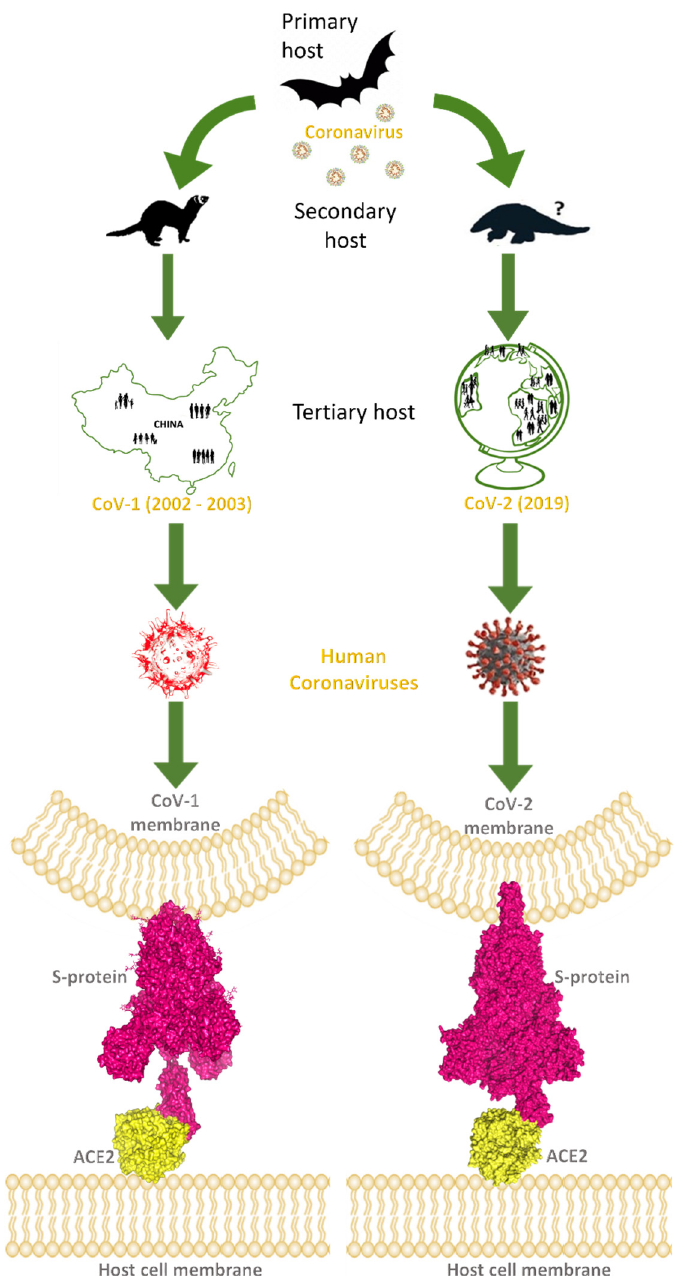
Figure 1. This image explains how coronaviruses spread from bats, as primary hosts, to humans, as tertiary hosts, showing complex spike–ACE2 interactions. Both originated from bats, considered natural reservoirs of SARS-like coronaviruses, CoV-1 and CoV-2 infected the human population via intermediate animal hosts in which viruses underwent an adaptation, exploiting their rapid evolution ability. In the case of CoV-1 (left side of the image), the intermediate host was identified in the masked palm-civets and, by subsequent mutations, CoV-1 became able to jump into humans (tertiary host) and led to the epidemic outbreak that emerged in China and spread in few other countries, to a lower extent, from the end of 2002 to 2003 July. For CoV-2 (right side of the image), the intermediate host is still uncertain, but was probably pangolin, from which CoV-2-related coronaviruses have been isolated. However, after the rapid evolution of these viruses in the secondary hosts, CoV-2 became able to infect the human population causing the COVID pandemic in 2019. Human coronaviruses can interact by the RBD of their trimeric spike glycoproteins, exposed on the membrane of viral envelope, with hACE2 proteins, expressed on the surface of host cells. At the bottom of the image, these interactions are visible for hACE2 and the CoV-1 spike (PDB code: